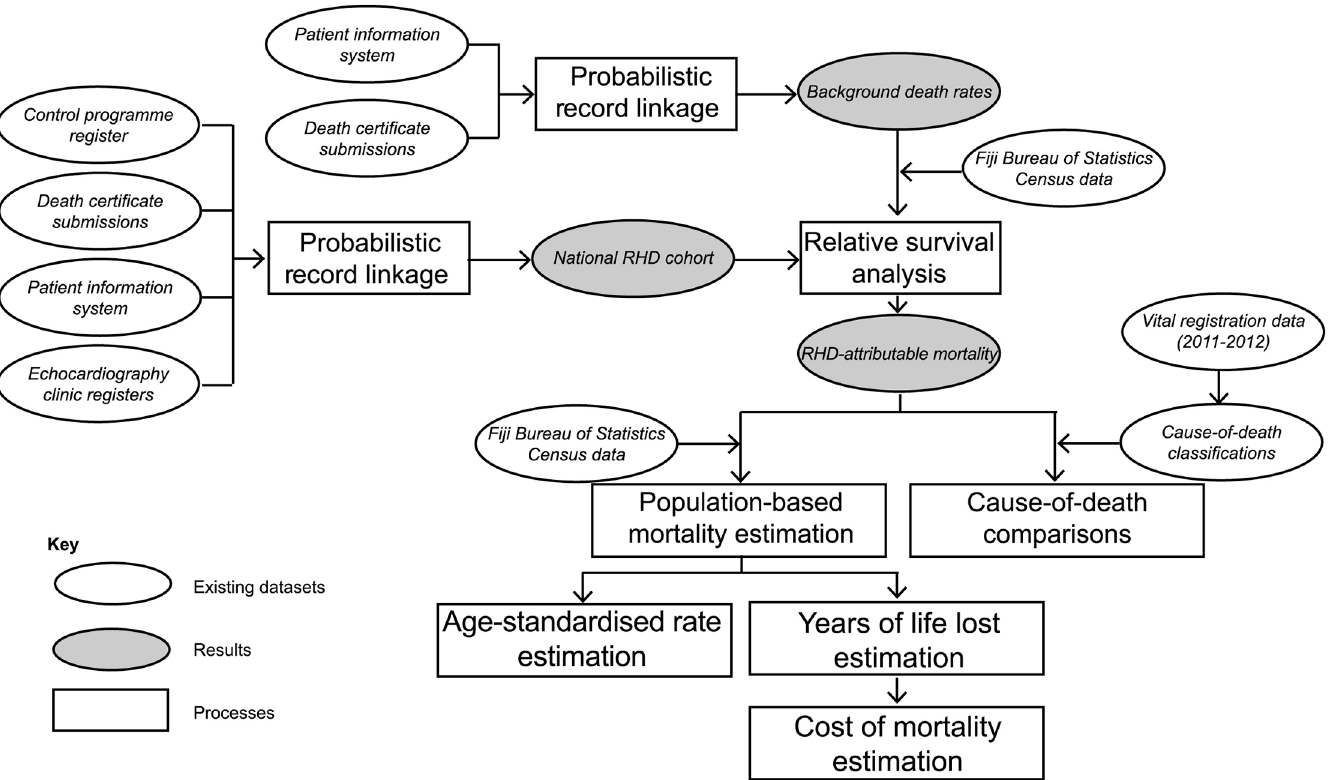
Fig 1. Overall design of the